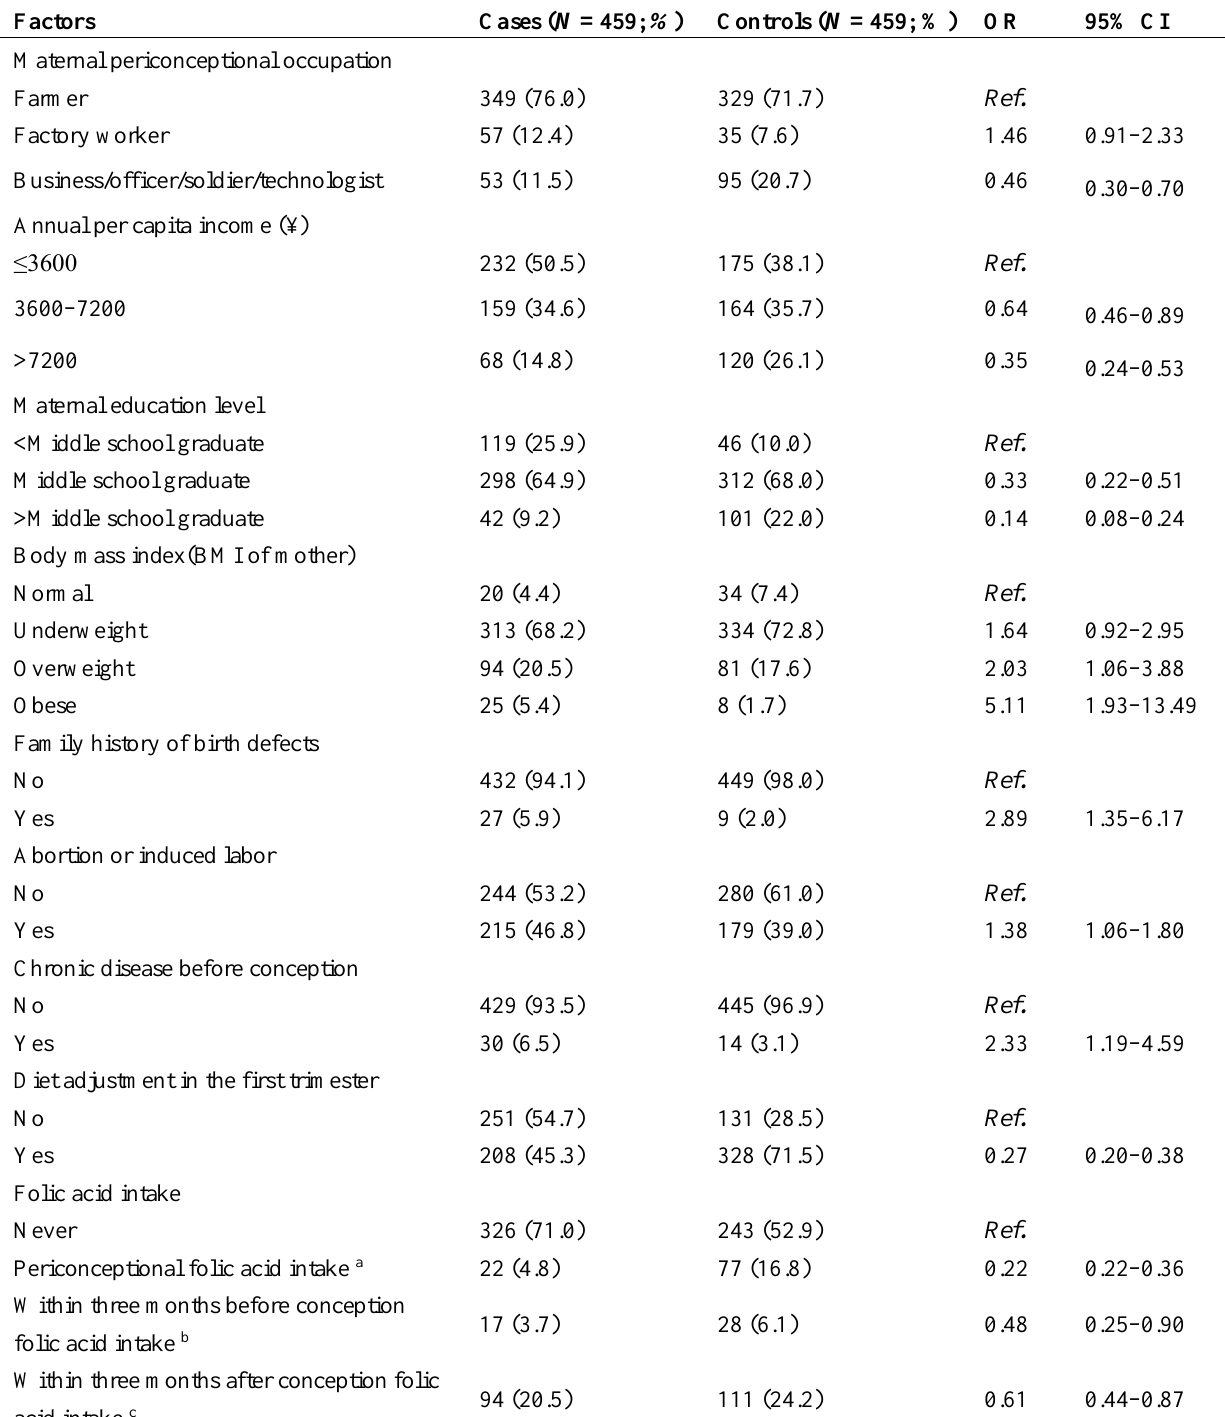
Table 1. Demographic and obstetric characteristics of subjects and their relationship with neural tube defects